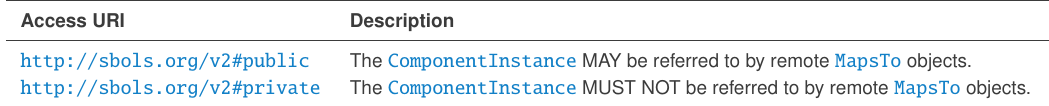
Table 5: REQUIRED URI s for the access